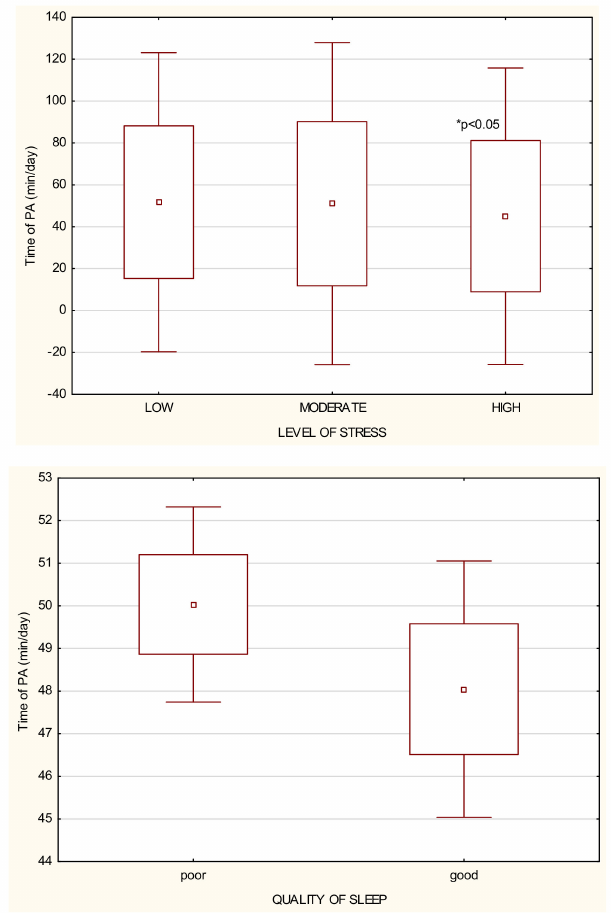
Figure 1. The relationship between the time of PA per day performed by the study participants ( n = 1956), the level of stress and the quality of